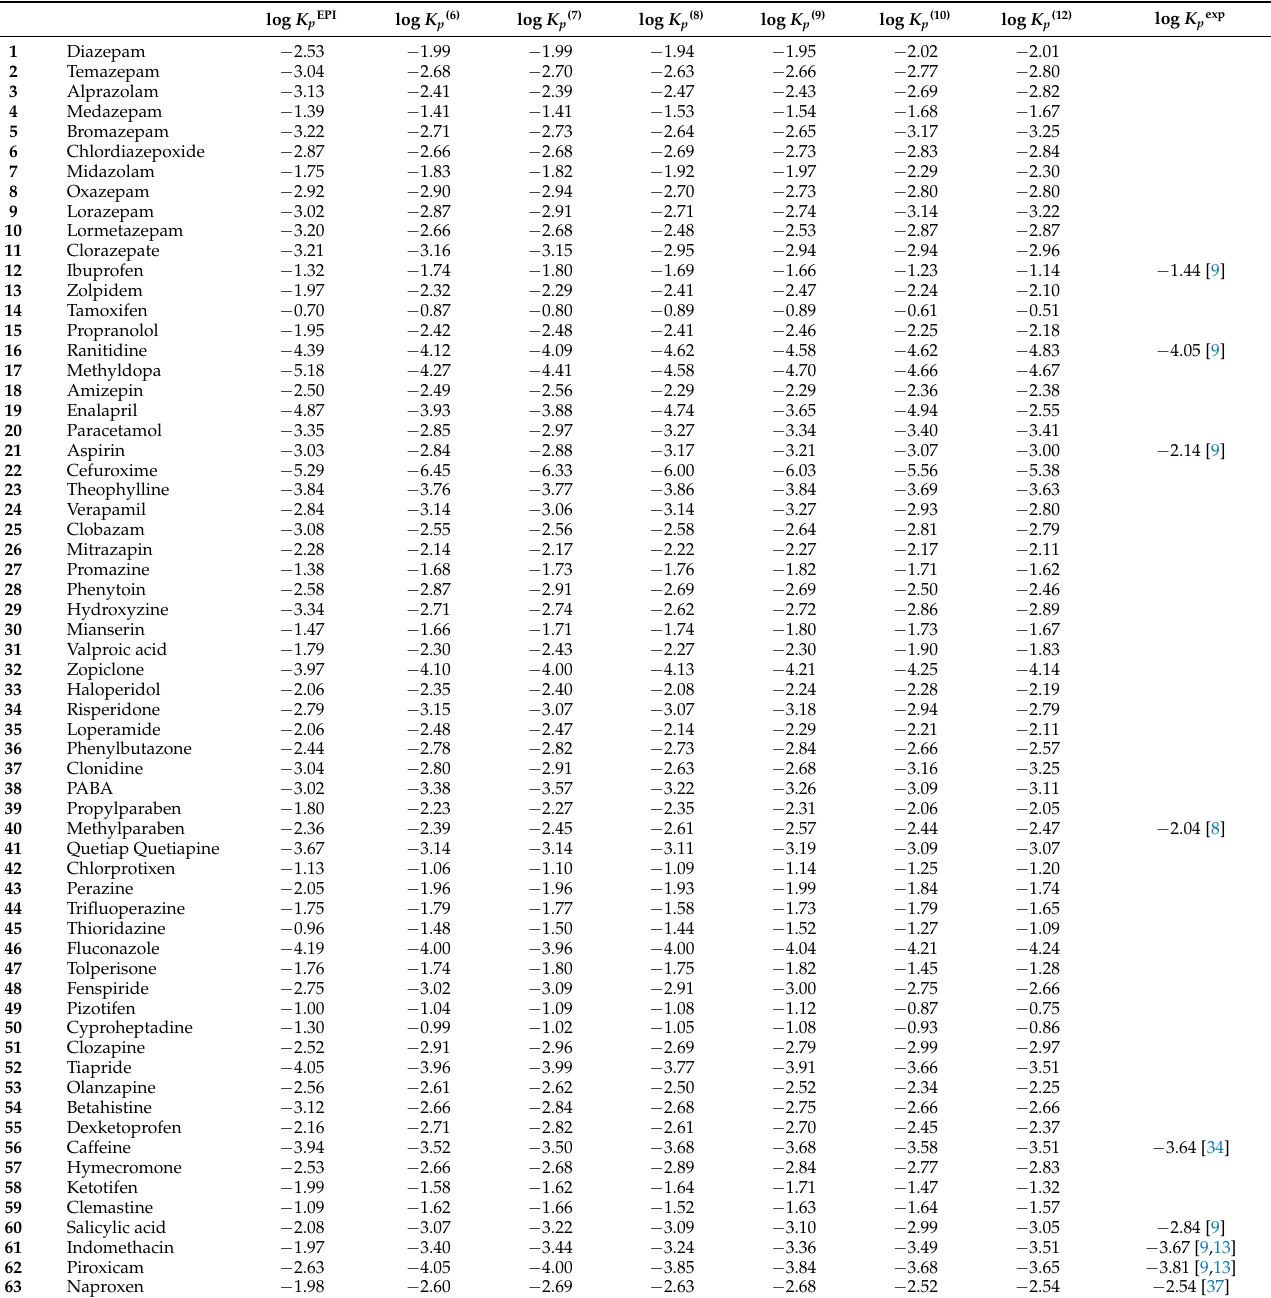
Table 3. Reference, experimental and calculated values of log K